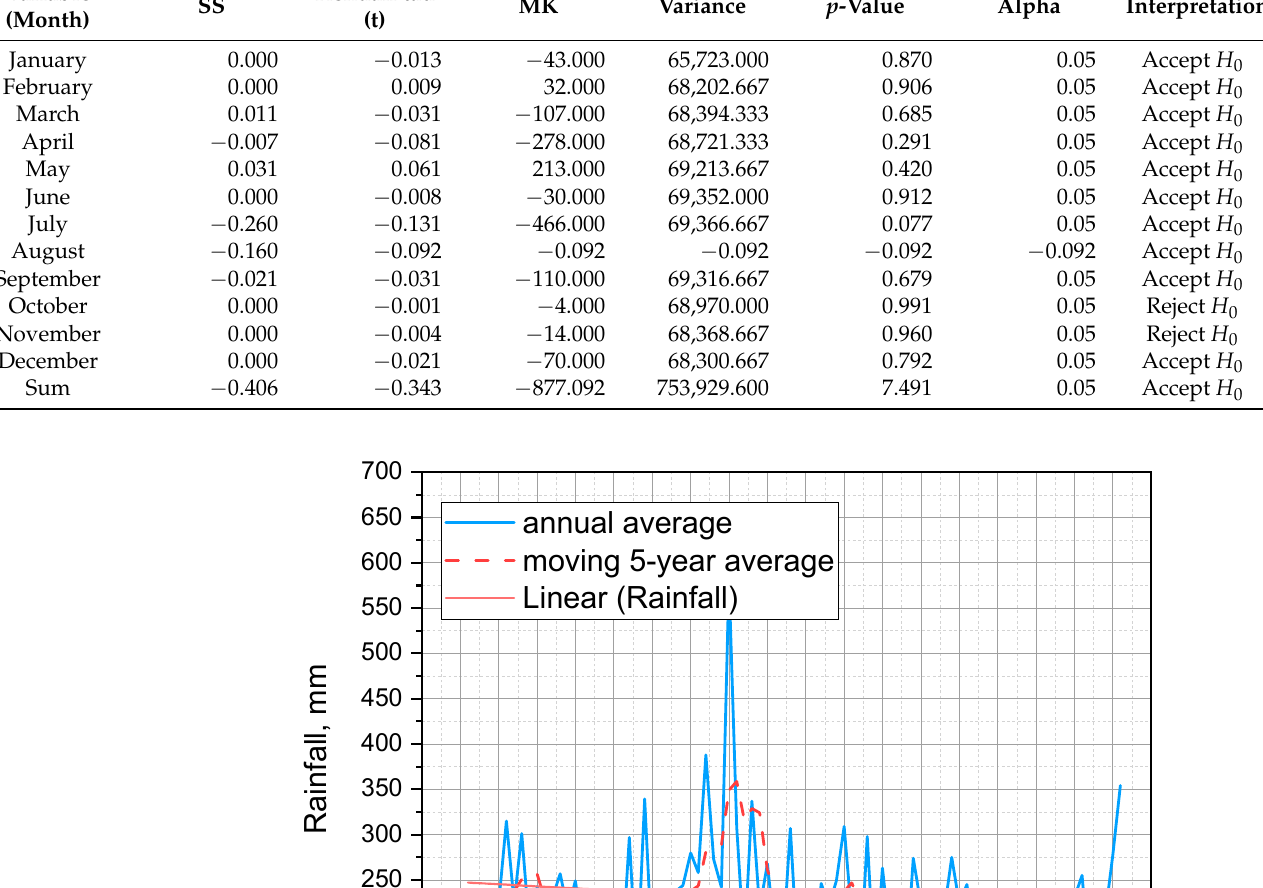
Table 5. Basic statistical characteristics of the Ulan-Ude rainfall data.